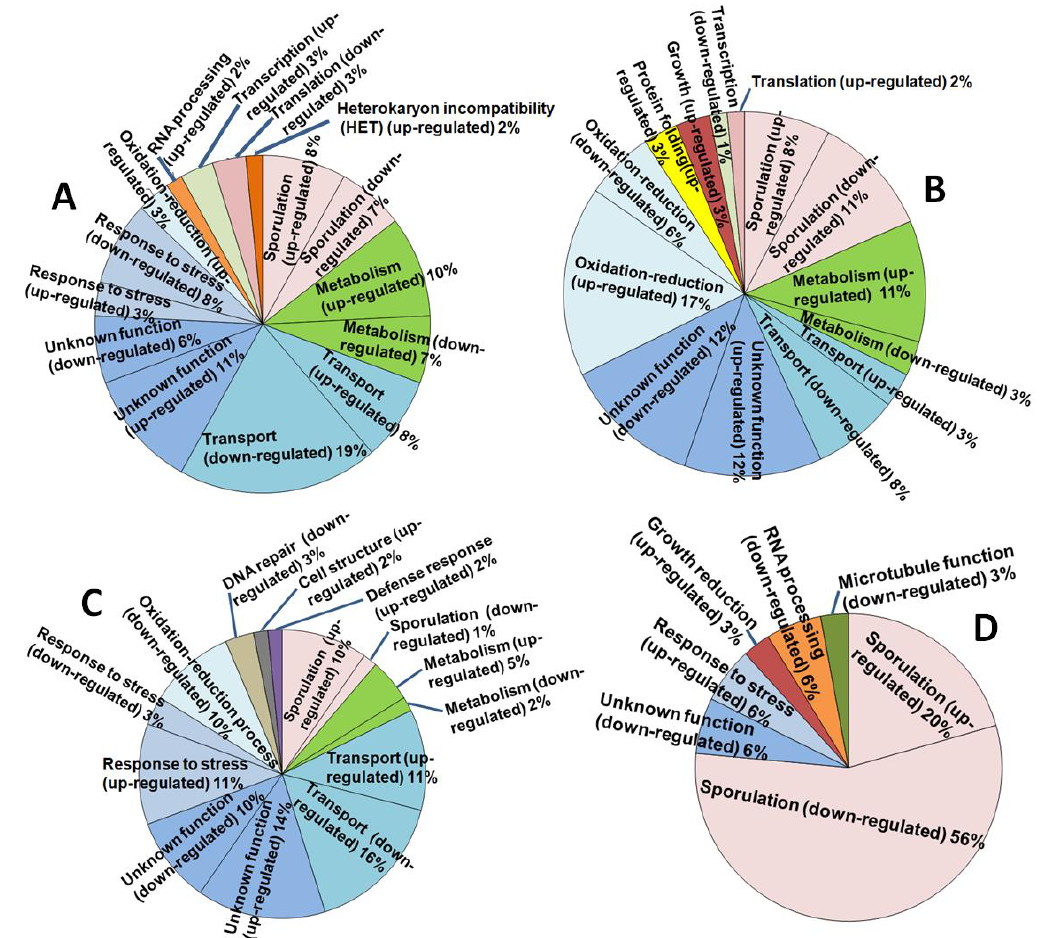
Figure 2. Differentially expressed genes in AthCV1-infected Aspergillus species and their functional analysis. ( A ) A. thermomutatus ; ( B ) A. niger ; ( C ) A. fumigatus ; ( D ) A. nidulans .